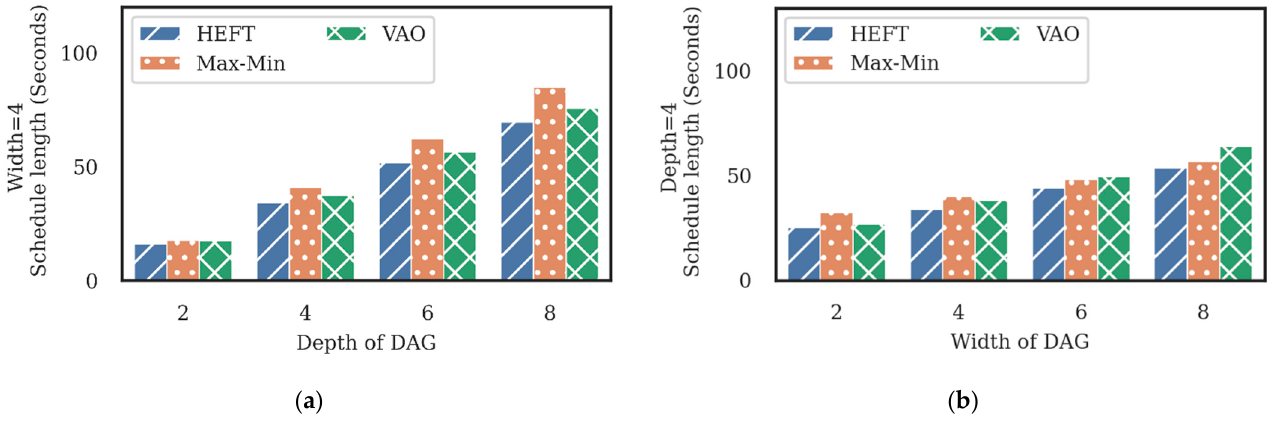
Figure 8. Initial schedule length according to the shape of the DAG: ( a ) Schedule length with varying depth of DAG; ( b ) Schedule length with varying width of DAG.